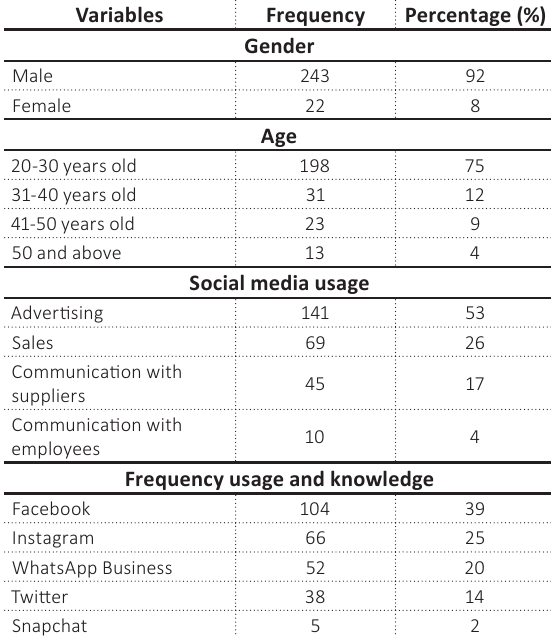
Table 1. Demographic